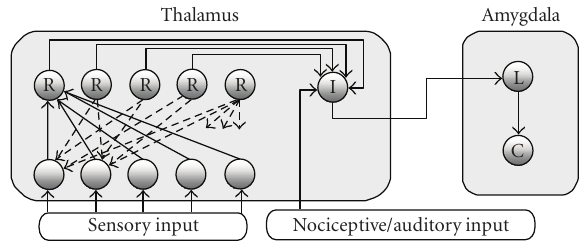
Figure 4: Hypothetical arrangement of thalamus and amygdala connections, used in the computational model that inspired the therapy here described (SLAT). R: thalamic reticular neurons; I: tha- lamic intralaminar neurons; L: lateral nucleus of the amygdale; C: central nucleus of the amygdala. Due to a competitive process per- formed between reticular neurons in the model, each one of them responds to a specific feature of a sensory pattern (Pel´aez [32, 33]). A similar competitive process takes place between intralaminar neu- rons, each one responding to a specific combination of features. Therefore, a certain number of features, that is, reticular neurons, are necessary for firing a specific intralaminar neuron. When this number is low, a low postsynaptic activity in intralaminar neuron favors synaptic depression, according to Figure 3, thereby reduc- ing the possibility of future intralaminar neuron firing. In this way, the thalamic-amygdala pathway is depressed in the computational